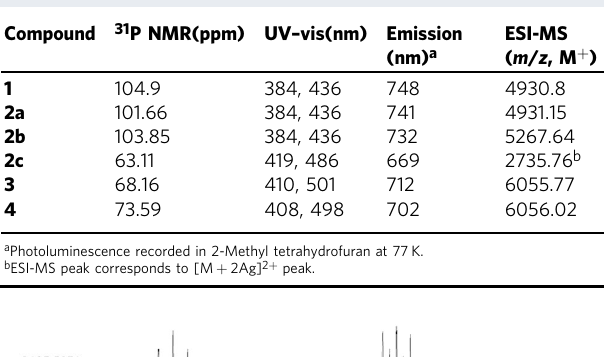
Table 1 Spectroscopic data of compounds for 1, 2(a – c), 3 and 4.